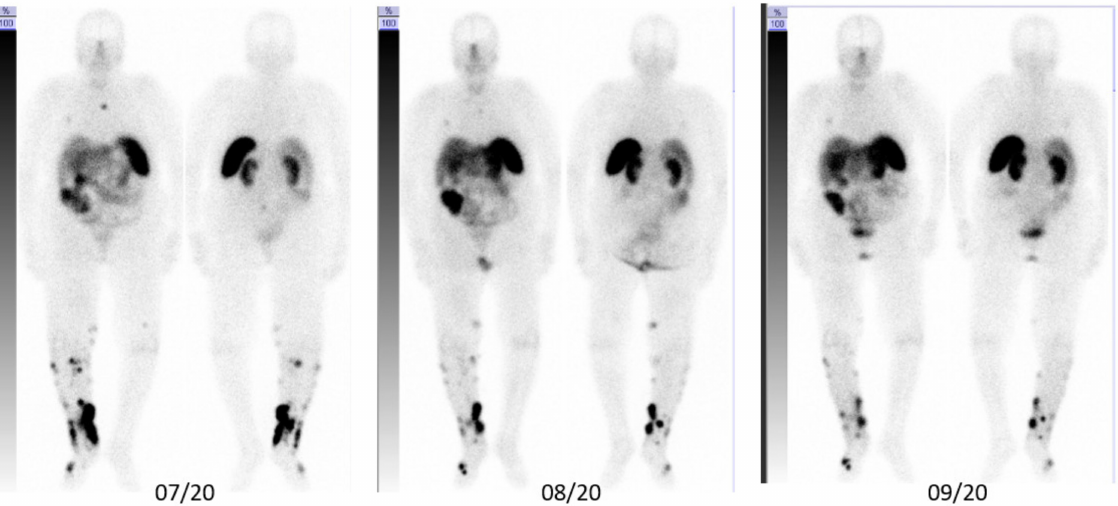
Figure 5. Anterior ( left ) and posterior ( right ) post-therapy scintigraphy images of patient B.